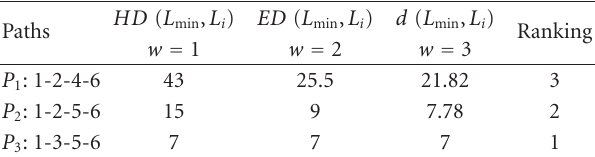
Table 6: Results of the network based on acceptability